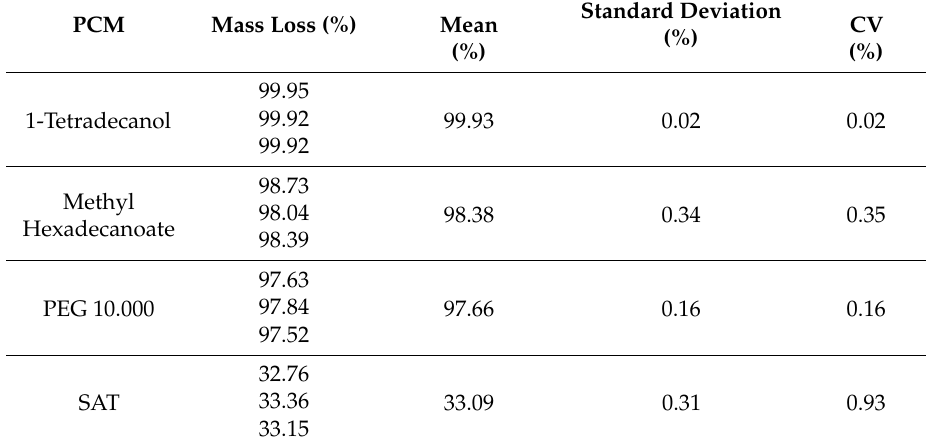
Table 3. Relative mass loss in decomposition, mean, standard deviation and CV of some of the studied